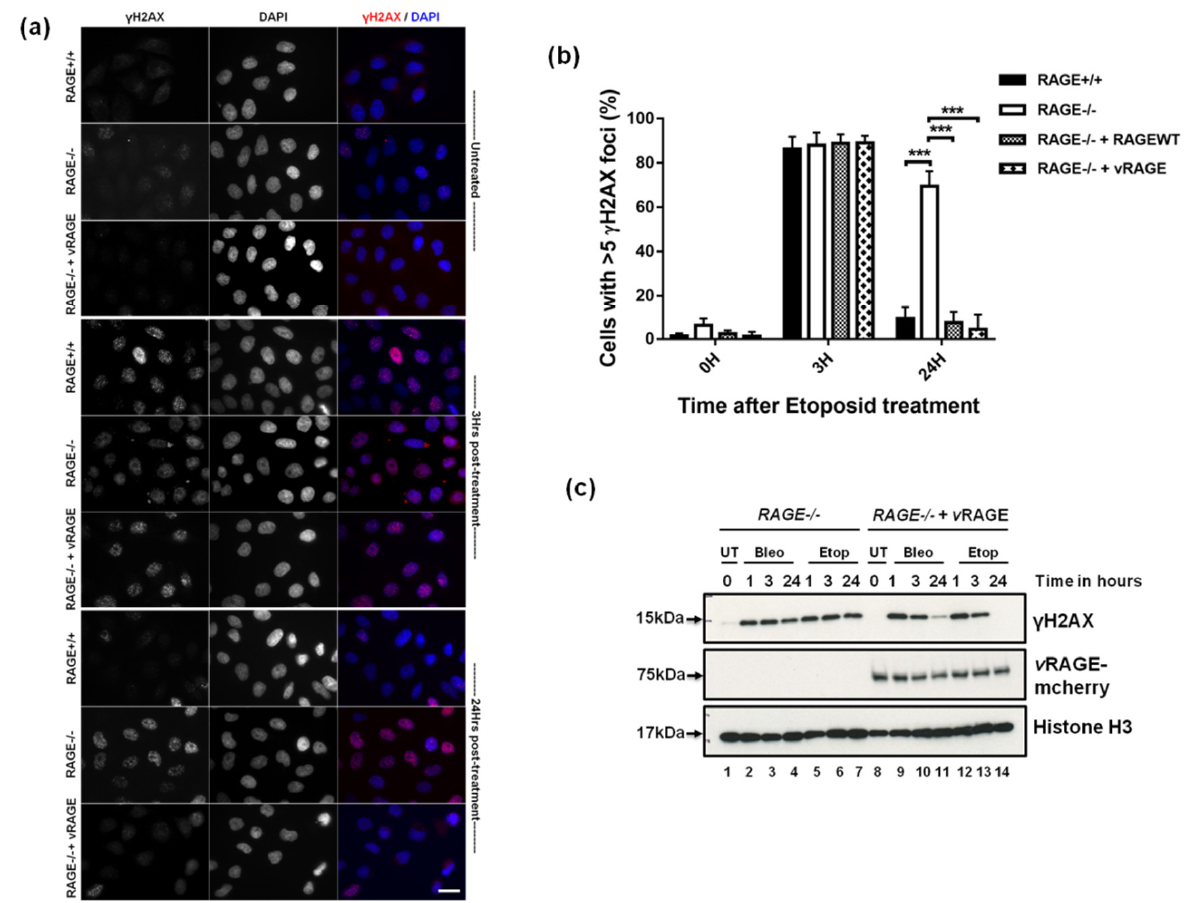
Figure 3. DNA damage-induced recruitment of vRAGE at the site of DSBs. ( a ) Immunofluorescence analysis of DSB associated foci as marked by γH2AX in un- or vRAGE complemented Hela −/− cells, treated with etoposide (2.5 µM for 1 h). Wild-type Hela cells (Hela +/+ ) served as an experimental control. The resolution of DNA-DSB foci, as marked by γH2AX, was monitored over 3 and 24 h after drug treatment; DAPI represents the nucleus (scale 10 µm). ( b ) Mean percentage of DSBs marker γH2AX positive nuclei of Hela cells as described in Figures 3a and S4a. More than 400 cells were analyzed for each bar (mean ± SD, ***: p < 0.001). ( c ) Representative immunoblots from the lysates of un-complemented (RAGE −/− ) or vRAGE complemented (RAGE −/− + vRAGE) RAGE −/− Hela cells, treated with etoposide (2.5 µM for 1 h) or bleomycin (30 µg/mL for 1 h) and probed for the DNA damage marker γH2AX at the indicated intervals after DNA damage. The expression of vRAGE was confirmed by using a vRAGE specific antibody. Histone H3 is used as a loading control.